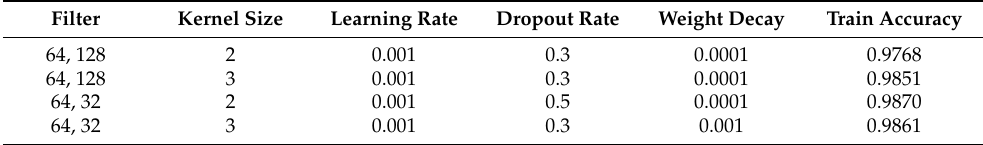
Table 1. Parameter optimization using GRID Searching for 1D-CNN. Filter